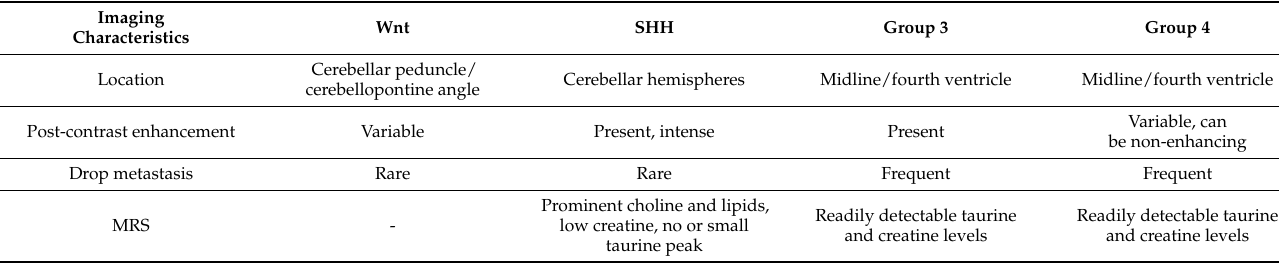
Table 2. Medulloblastoma: molecular subgroups